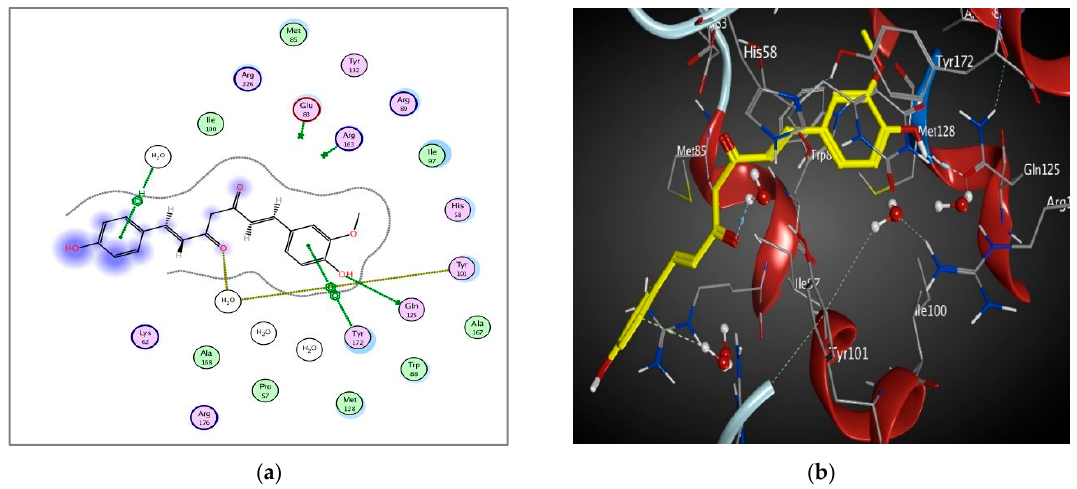
Figure 8. 2D diagram ( a ) and 3D representation ( b ) showing the binding mode of curcumin (yellow) with the 1E2P thymidine kinase binding pocket.